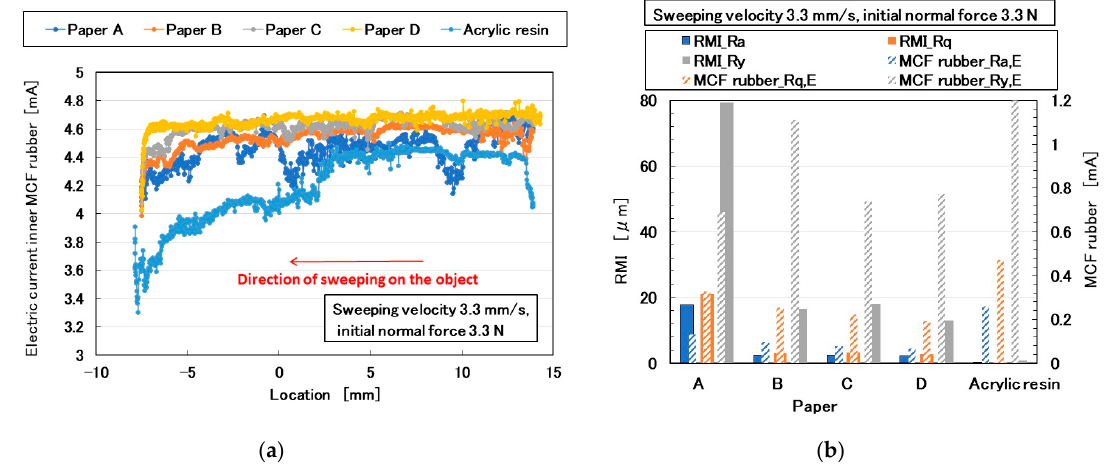
Figure 16. Results of paper by the MCF rubber sensor under shear motion: ( a ) electric current; ( b ) Ra ,E , Rq ,E , Ry ,E of ( a ), RMI_Ra , RMI_Rq , and RMI_Ry of paper. Rq ,E , Ry ,E of ( a ), RMI_Ra , RMI_Rq , and RMI_Ry of